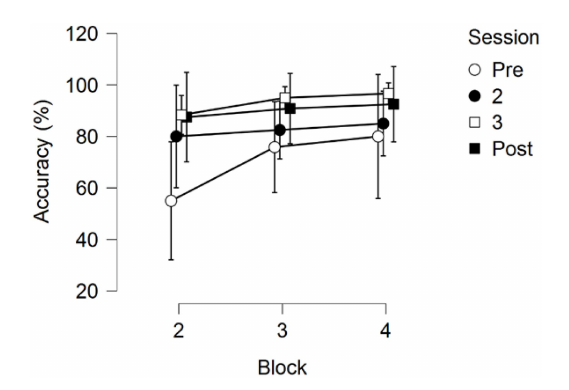
FIGURE 6 Response Accuracy across the three testing blocks for the four training sessions. Error bars represent 95%